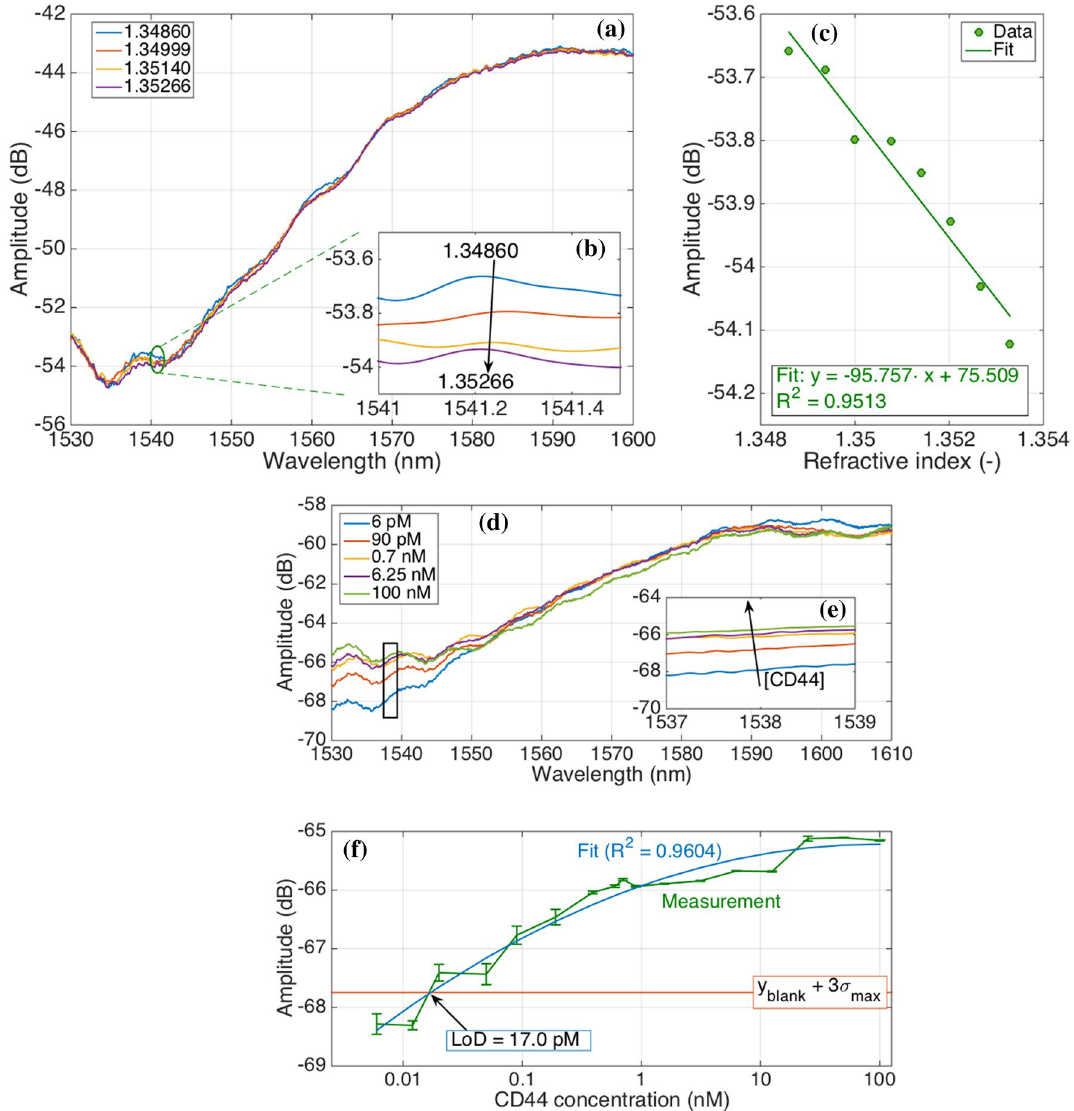
Figure 2. Performance of fiber optic spherical tip sensor in terms of RI sensitivity and CD44 protein detection. (a–c) RI calibration of fiber optic spherical tip (548–544 µm) after gold coating in different sucrose concentrations: 10.49% to 13.53% in 8 steps of 0.49%, corresponding to RI values of 1.34860 to 1.35329, for a total change of 4.69 × 10 –3 RIU in steps of 5.86 × 10 –4 RIU. (a) Spectra showing the change of amplitude of the sensor in four sucrose concentrations; (b) inset showing integrated spectral response in the range where the sensor had the highest response (between 1541 and 1541.5 nm) for sensitivity estimation; (c) amplitude change as a function of RI change; curve processed with linear regression, R2 = 0.9513 with an estimated sensitivity = 95.76 dB/RIU. (d–f) CD44 protein detection by fully functionalized spherical fiber optic tip biosensor; (d) Amplitude change occurring during measurement of different concentrations of CD44 protein by the biosensor; (e) an inset showing integrated spectral response in the range where the sensor had the most sensitive response (between 1537 and 1539 nm) for LoD estimation; (f) amplitude change as a function of protein concentration; the blue line represents the fitting of the experimental data by using second-order polynomial